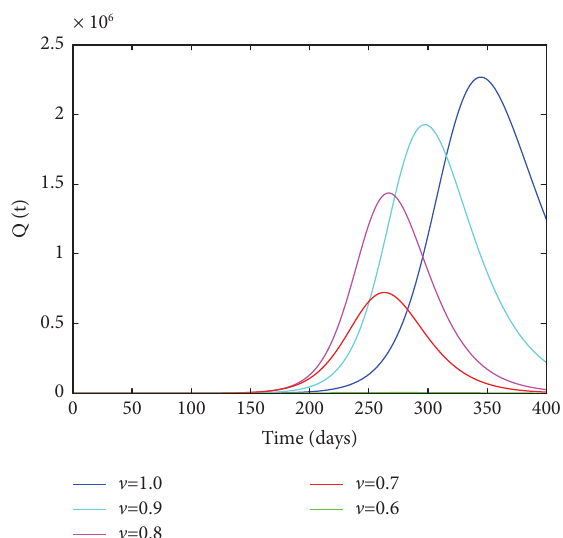
Figure 6: Behaviour of the quarantine individuals at diferent values of v